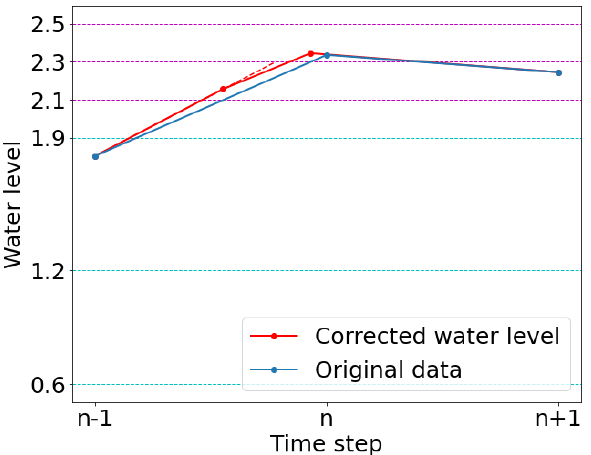
Figure 7. Illustration of case A2: f n − 1 = 1.804, f n = 2.336 and f n + 1 = 2.245. The dotted extension of the first line segment shows how the slope of the water level decreases after the first break point. In